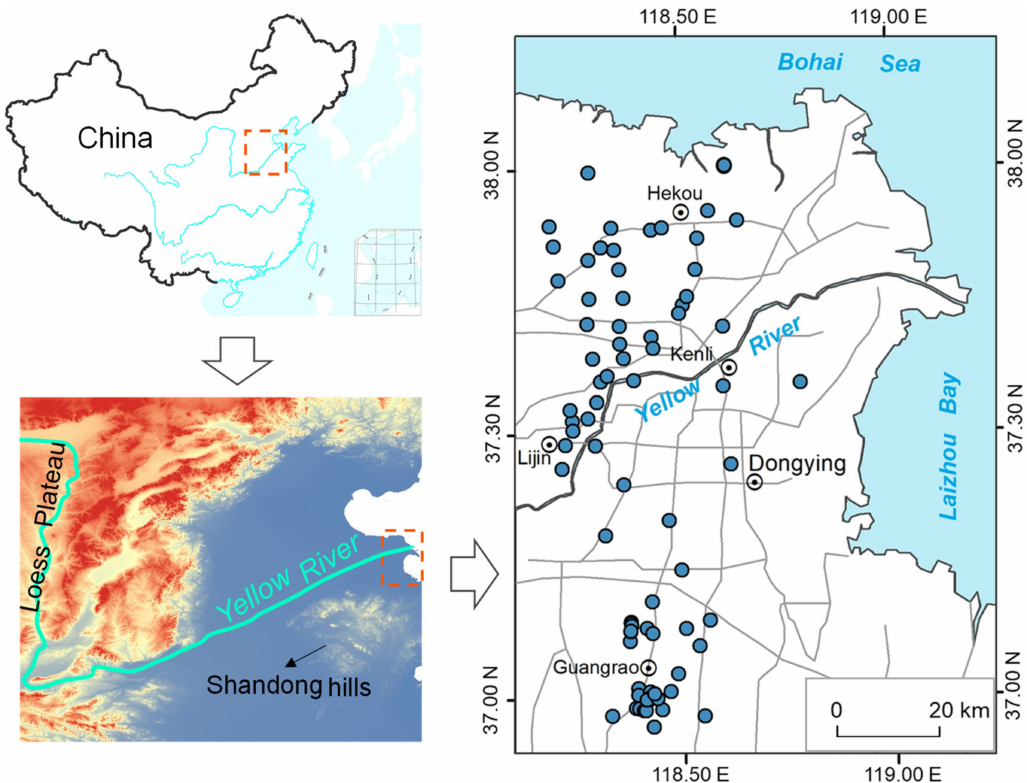
Figure 1. Location of the study area and groundwater sampling